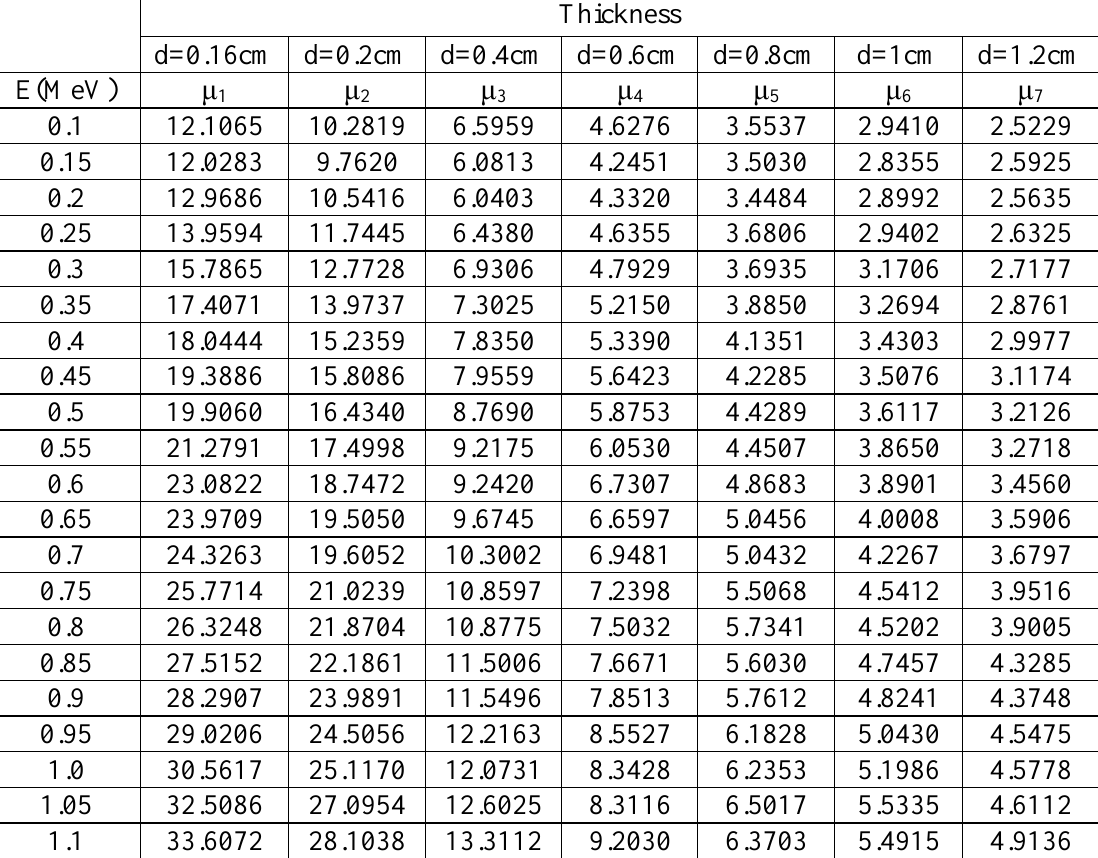
Table 1: Linear attenuation coefficients for different thickness of polymer composite (cm -1